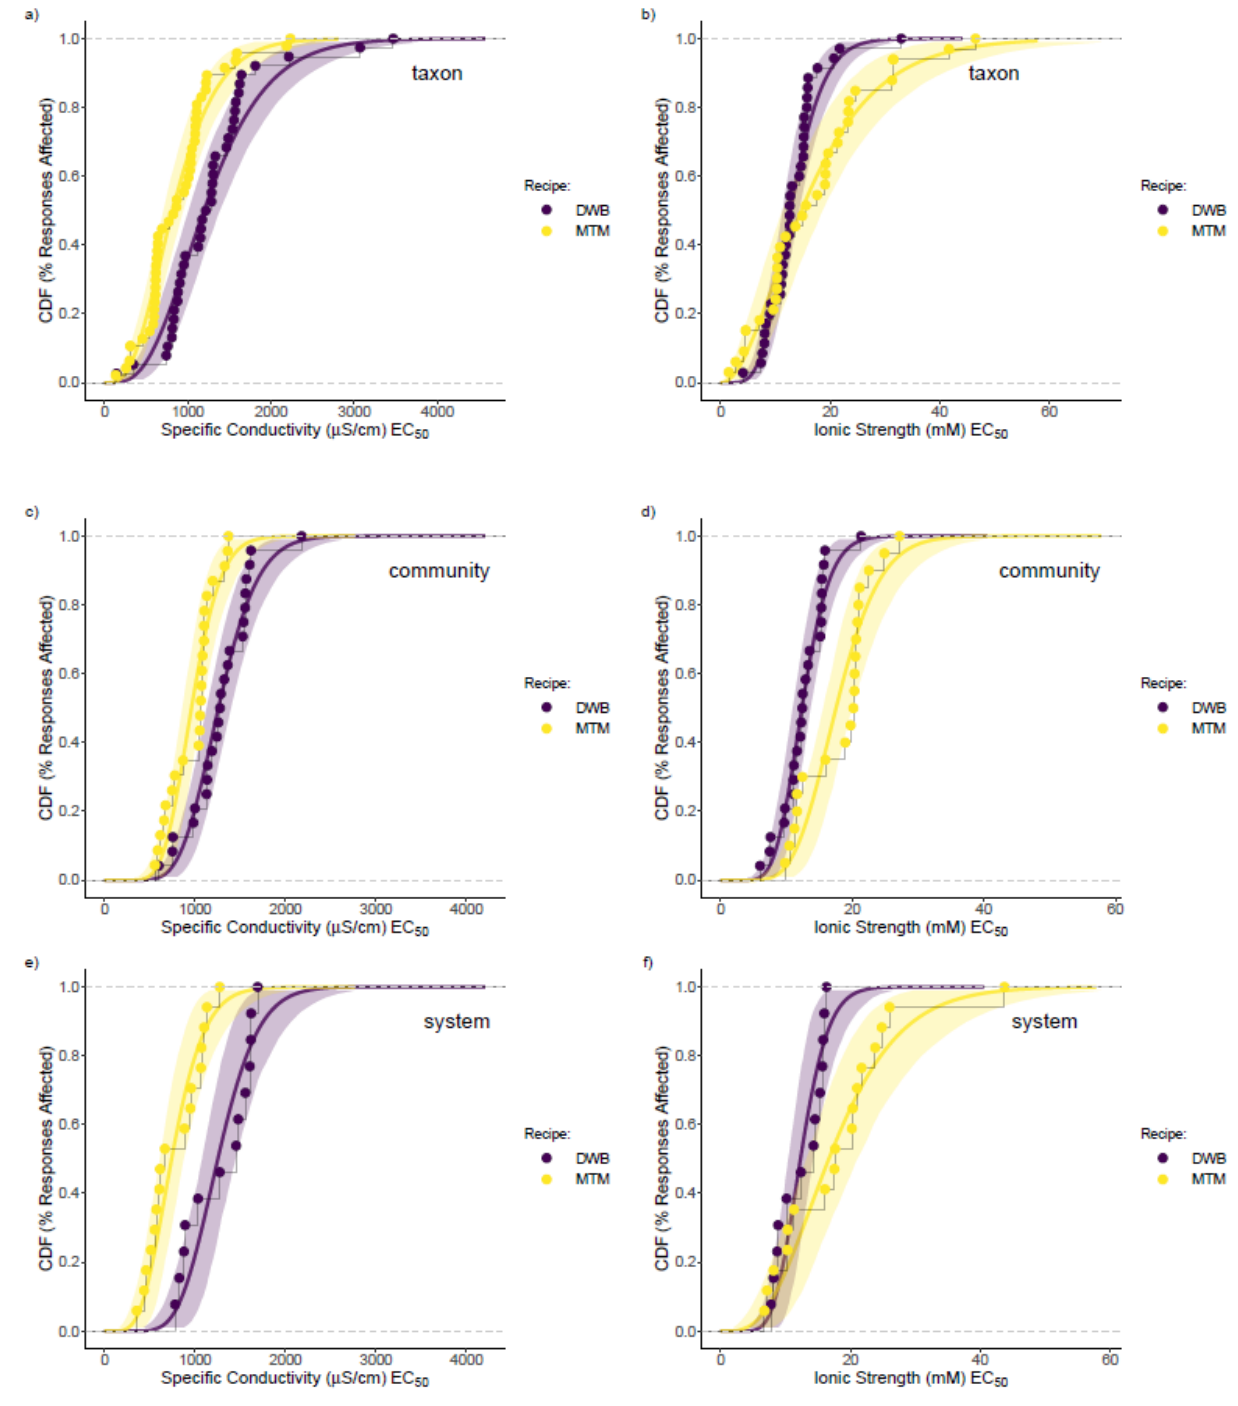
Figure 5. Dosing recipe EC 50 RSD comparisons grouped by levels of ecological organization. The shaded area about each curve represents the 95th prediction probability for the best RSD fitting function. Left panel of graphs ( a – c ) are based on EC 50 SpCond. Right Panel graphs ( d – f ) are based on ionic strength.